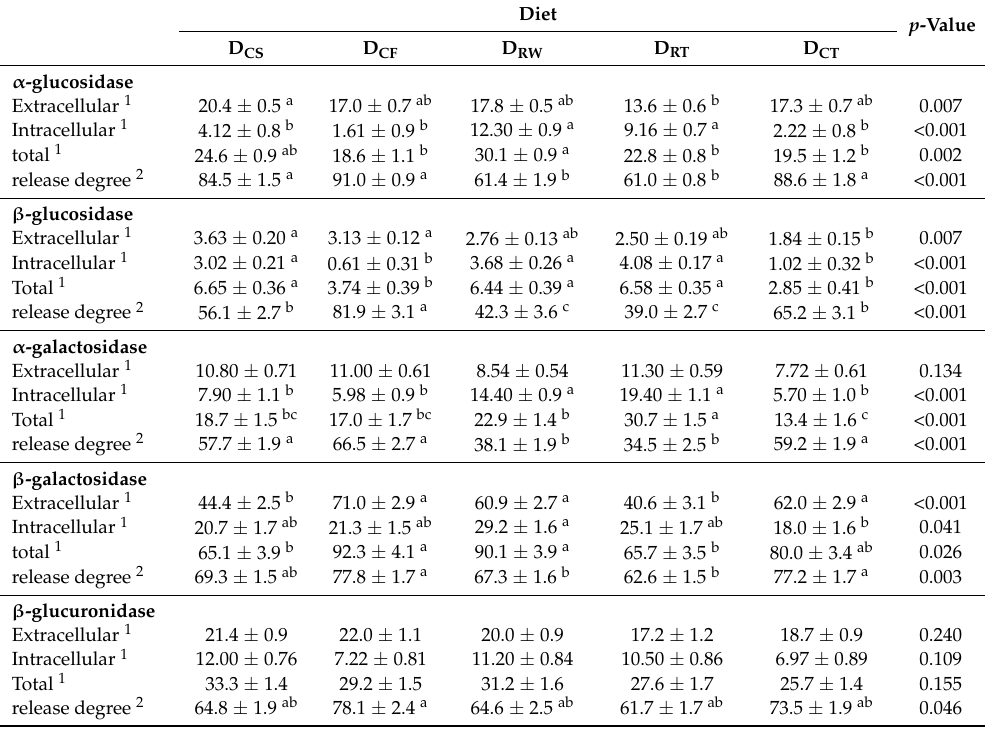
Table 3. Activity of the selected bacterial enzymes in the rats’ cecum content at the end of the experiment. Data are expressed as mean ± SEM, n =